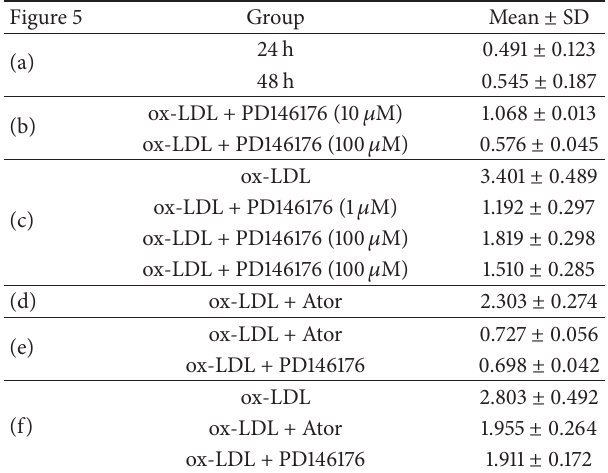
Table 5: Numbers in results.